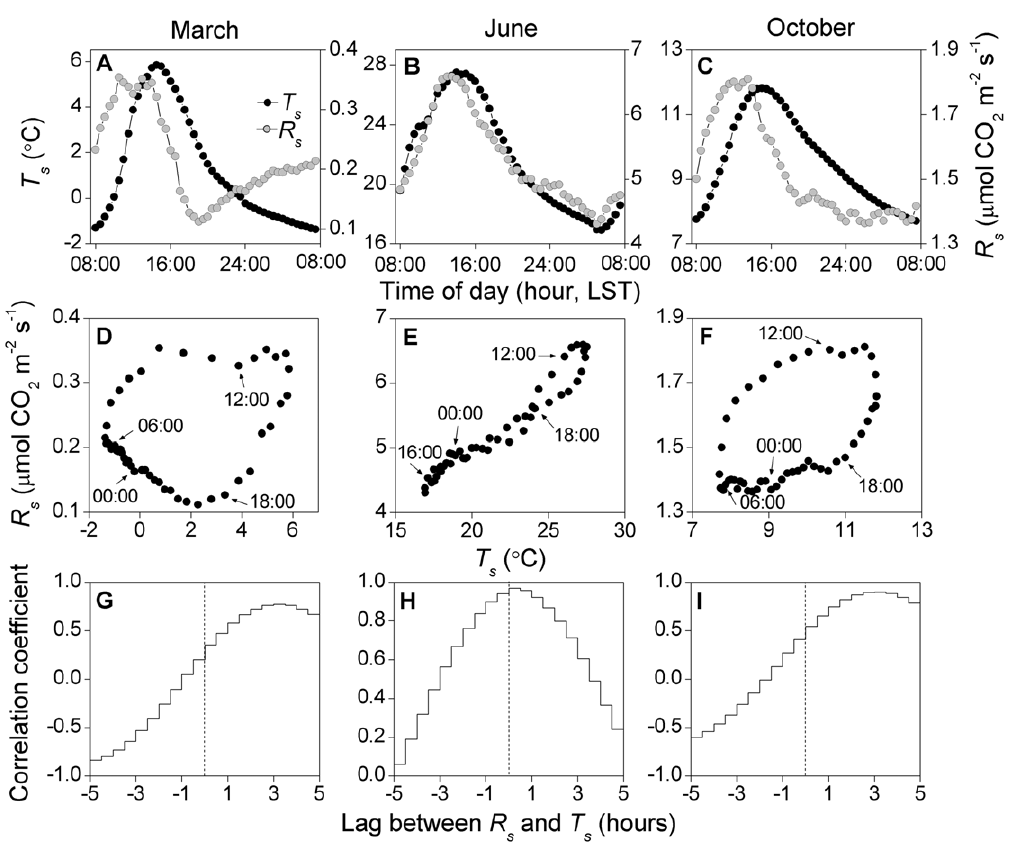
Figure 6. Diel soil respiration ( R s ) and temperature ( T s ) (A–C), diel R s vs. T s (D–I), their lag correlations (G–I). Mean values for March, June and October are shown. Grey circles in (A–C): R s ; Black circles in (A–C): T s . T s was monitored at 10-cm depth. The dashed lines in (G–I) are reference lines for the zero lag.